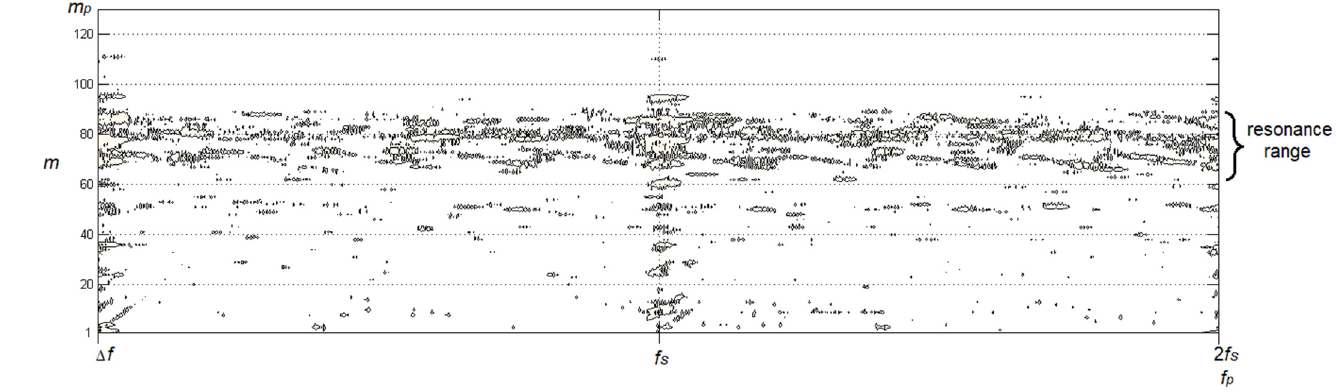
Figure 2. F-F image of the frequency spectrum of the vibration acceleration of the outer casing of a healthy motor ( f P = 2 f s ).